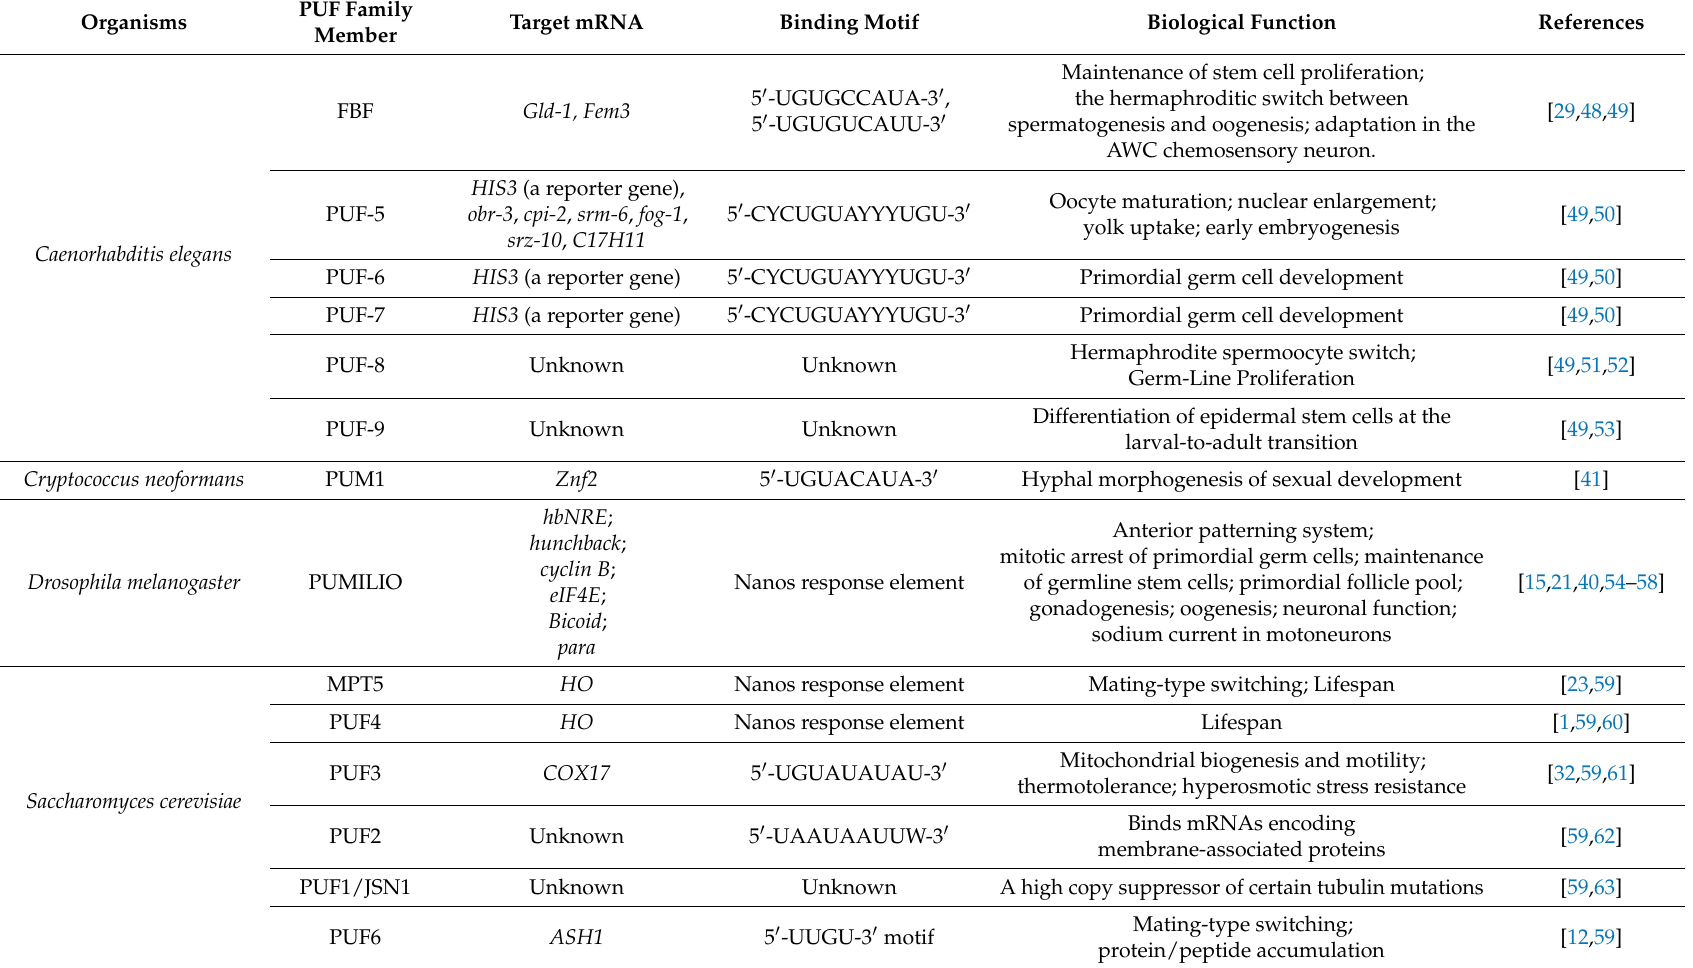
Table 1. Biological functions, binding motifs, and target mRNA of some of the most described PUF proteins in different living